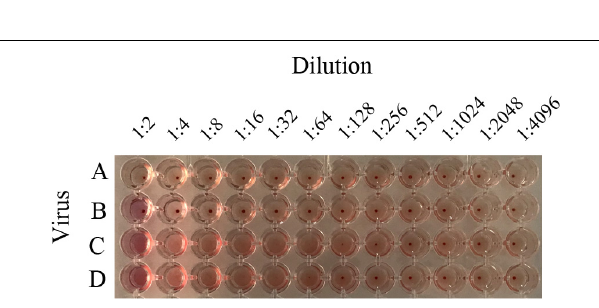
FIGURE 4 | Hemagglutination titers of H3N2 mutant strains. To distinguish whether the possessing of glycosylation motif site at position 158 failed to bind RBCs, recombinant virus containing HA1-160K, HA1-158K, and LZP were determined by HA assay. A: PBS; B: LZP; C: T160K; D: N158K.